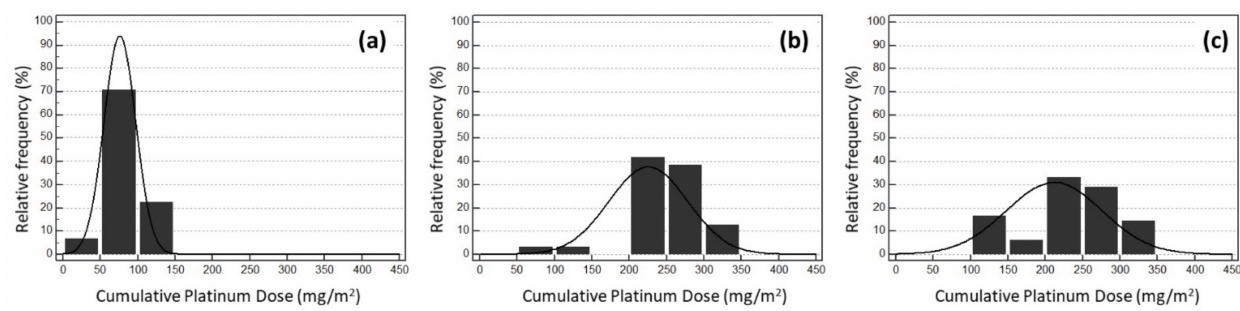
Figure A4. Distribution of cumulative platinum doses in the development cohort (panel ( a )) and in the two validation cohorts (panels ( b , c